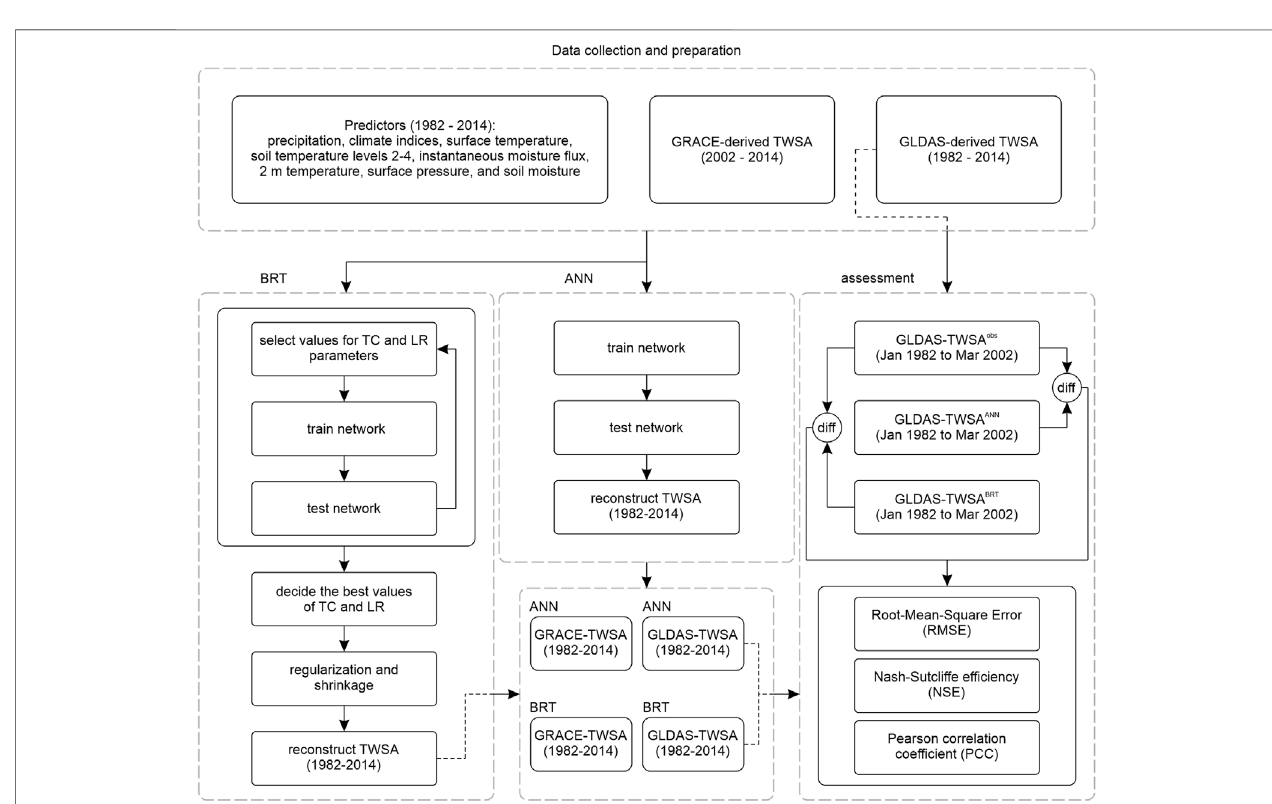
FIGURE 3 | Flowchart of the primary process steps to reconstruct the GRACE-derived terrestrial water storage anomaly (TWSA) based on BRT and ANN (NARX) algorithms. The fl owchart also shows the steps necessary for evaluating the reliability of the reconstructions using GLDAS – VIC-simulated TWSA.